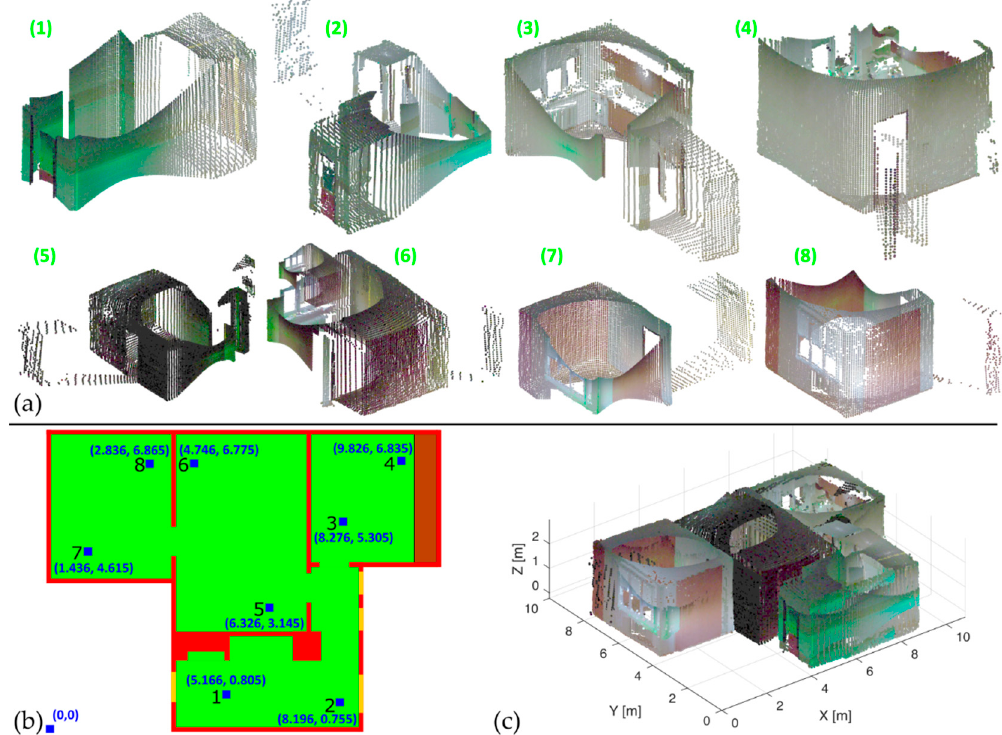
Figure 18. Input point cloud of the flat with marked scan positions: ( a ) Individual 3D scans, green number in bracket is equal with the scanning positions in ( b ); ( b ) Flat top view scheme with marked measurement positions; ( c ) Composed final point cloud.